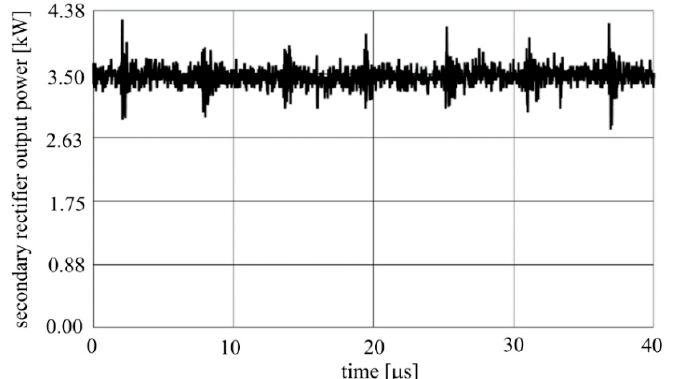
Figure 16. Measured output secondary rectifier power in nominal conditions. The surges in the waveform of the power from the secondary rectifier are caused by the switch ringing and are more evident in correspondence to the instants when the conduction of the MOSFETS begin.